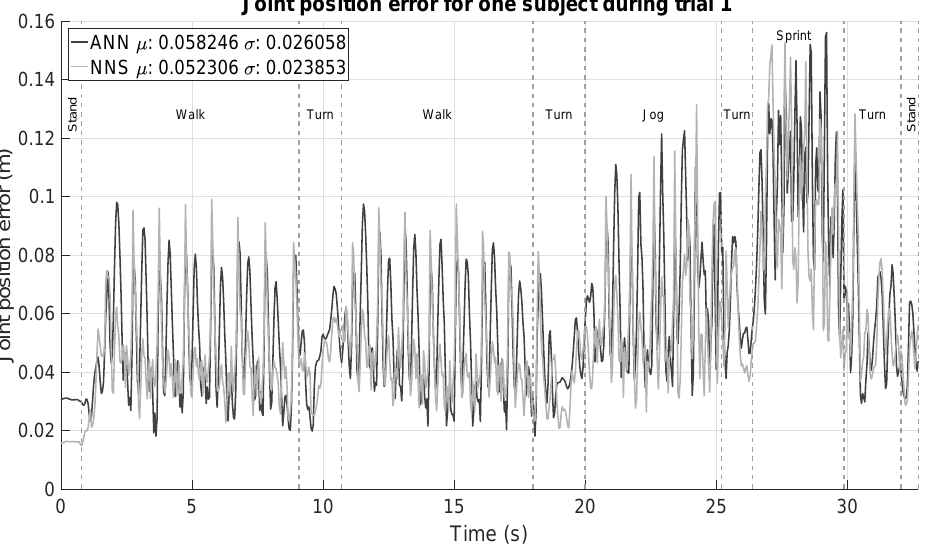
Figure 6. Average joint position error (using configuration D) of one subject during the first trial. Vertical dashed lines are shown to denote the different movements in that part of the trial.